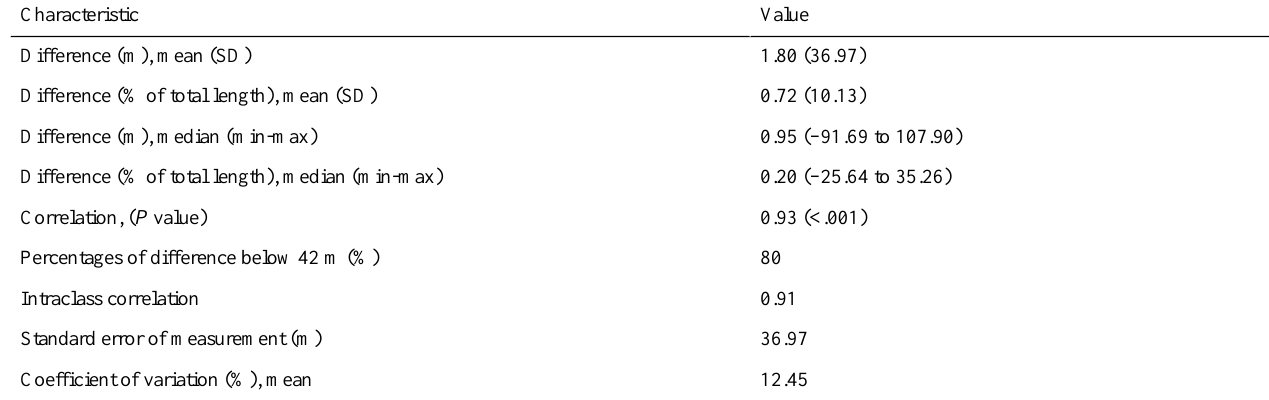
Table 3. Differences between the 6-minute walk test distances (6MWDs) of 89 pairs of community-based 6MWDs measured by the app in outdoor mode no more than 7 days